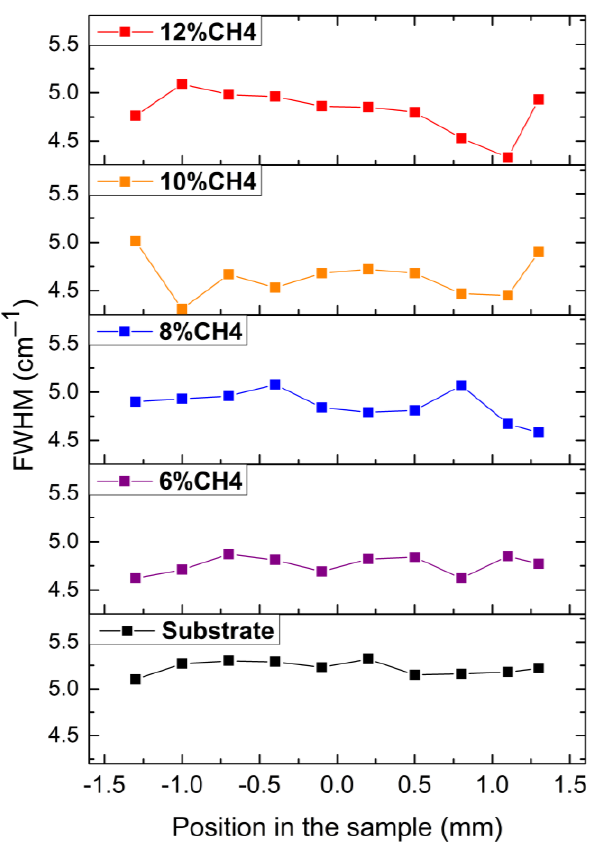
Figure 2. FWHM of the Raman spectra of diamond films grown under different CH 4 gas concentrations as a function of the position at the sample surface.